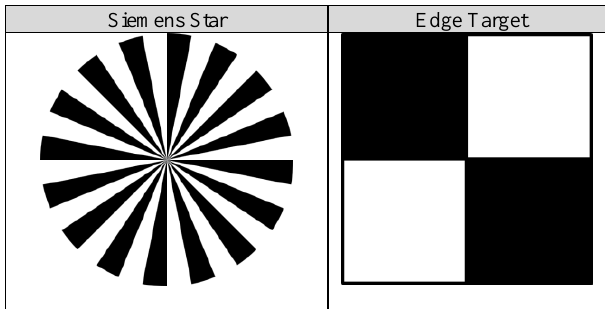
Table 2. Artificial target for edge analysis